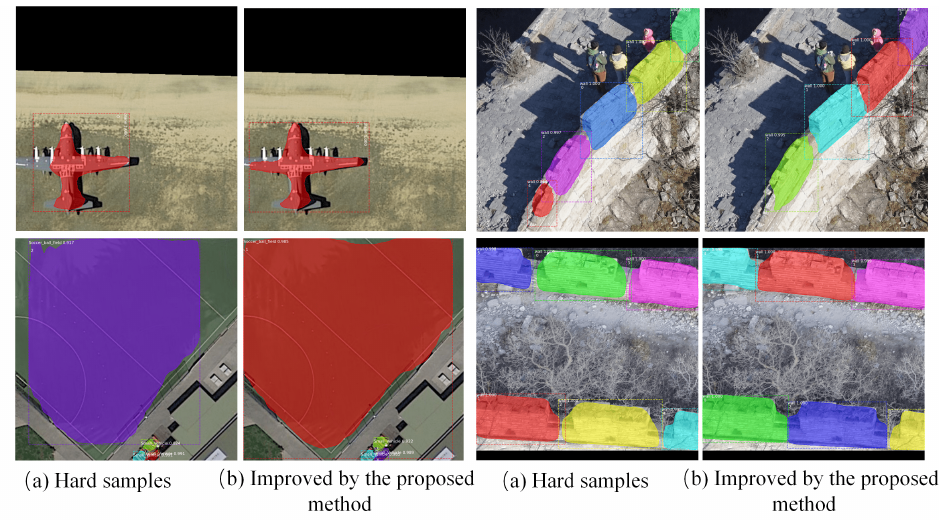
Figure 1. We propose an ensemble method to tackle the problem of inaccurate instance segmentation in remote sensing imagery, which takes advantage of hard instance learning and boundary shape analysis. ( a ) depicts hard samples that commonly exist and hamper the instance segmentation. ( b ) shows the improved segmentation results using the proposed